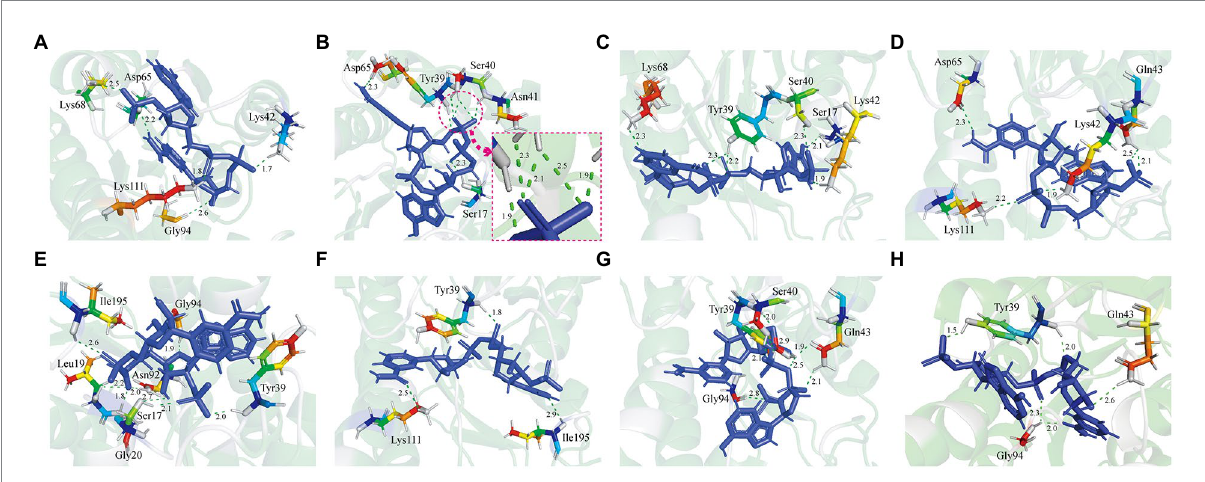
FIGURE 1 Analysis of the interaction between Glucose dehydrogenase (GDH) mutants and NADP + . (A) GDH-NADP + complex. (B) P45A-NADP + complex. (C) Q252L-NADP + complex. (D) F155Y-NADP + complex. (E) W230F-NADP + complex. (F) N46E-NADP + complex. (G) V227A-NADP + complex. (H) E170R-NADP + complex. The protein-ligand interactions between GDH mutants and NADP + were studied using Discovery Studio 3.0. The green dashed line represents the hydrogen bonds. The unit of bond length is angstrom